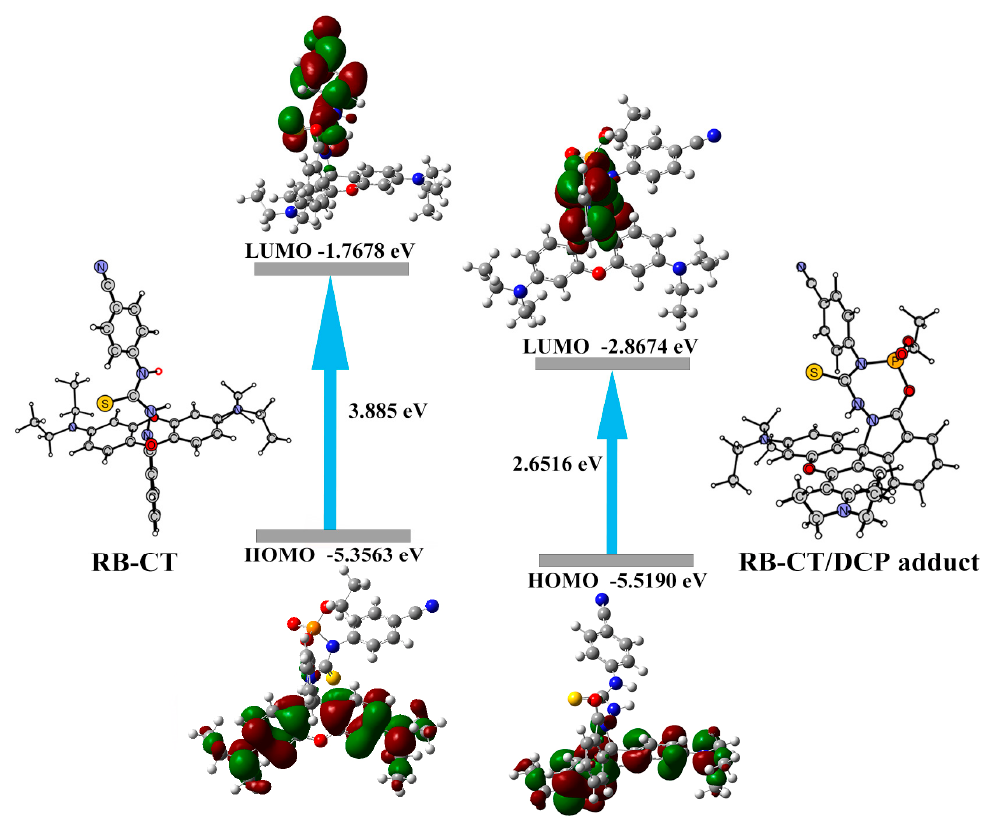
Figure 3. Energy optimized structures, HOMO-LUMO energy levels, and interfacial plots of the orbitals of RB-CT and RB-CT/DCP